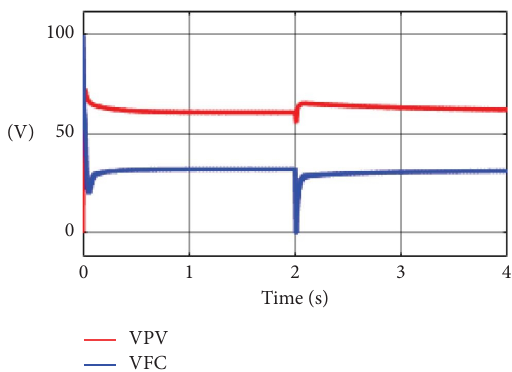
Figure 16: V PV and V FC in the frst operation mode.